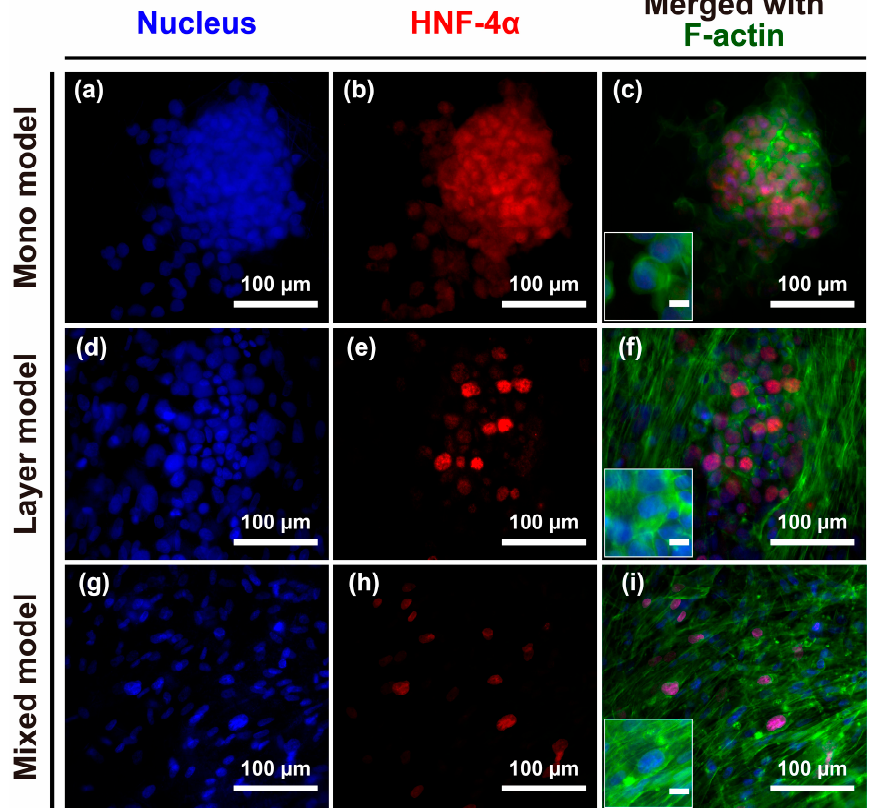
Figure 2. ( a – i ) Structural morphology of cancer cells and fibroblasts or cancer cells alone on the nanofibrous membrane after seven days of culture. Immunofluorescence of DAPI-stained nuclei (blue), hepatocyte nuclear factor 4 alpha (HNF4 α , red), and the cytoskeleton protein F-actin (green). Merged images of the experimentally designed mono model ( c ); layer model ( f ); and mixed model ( i ). Unmarked scale bars, 10 μ m.